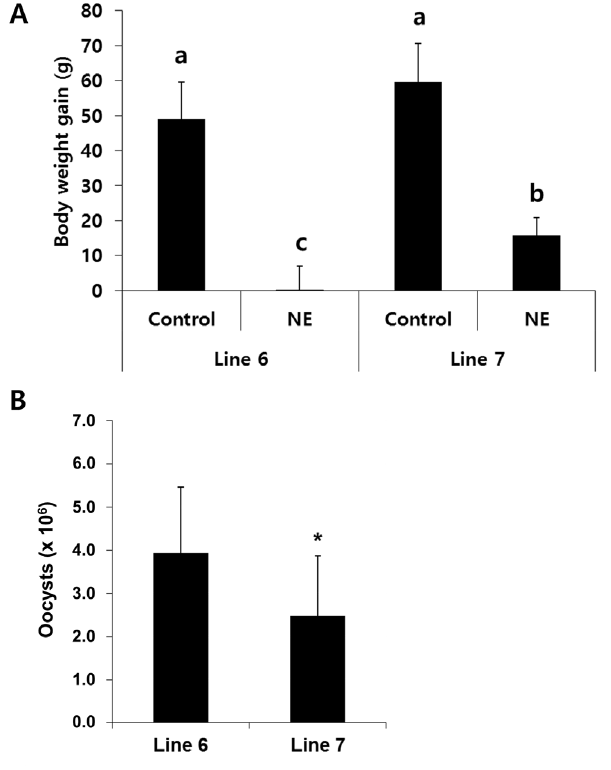
Fig. 4. Effect of C. perfringens / E. maxima co-infection of ADOL line 6 and line 7 chickens on body weight gains and oocyst shedding. (A) Chickens were uninfected (Control) or co-infected with C. perfringens and E. maxima (NE) and body weight gains were measured between days 0–9 post-infection with E. maxima . Bars with different letters are significantly different according to the Duncan’s multiple range test ( P , 0.05). (B) Fecal oocyst shedding was measured between days 0–9 post-infection with E. maxima in C. perfringens / E. maxima co-infected chickens. Each bar represents the mean ¡ SD value (n 5 8). *, P ,